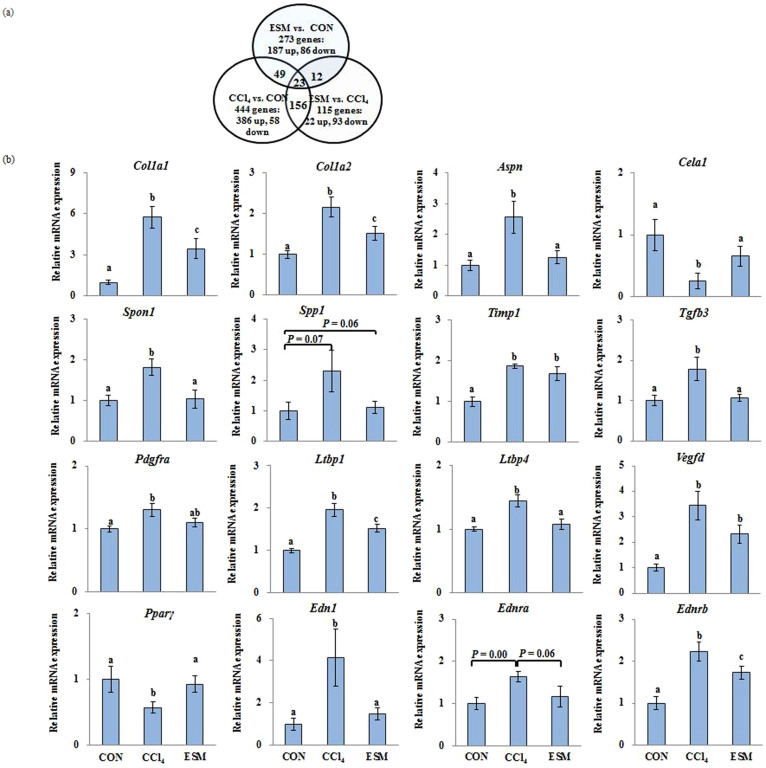
Venn diagrams of differentially expressed genes (more than 1.5-fold) in the liver (a). Each of the circles represents the genes in the respective comparison. The numbers in the spaces between overlapping circles represent the number of genes that were commonly changed in the two comparison. (b): Quantification of gene expression of key genes involved in ECM turnover and profibrogenesis. CON, control rats; CCl4, rats administered CCl4; ESM, rats given CCl4 and ESM (20 g kg−1). Results are means ± SE in each group (n = 6). Data with different letters (a,b,c) are significantly different (P < 0.05) by Dunnett's test.